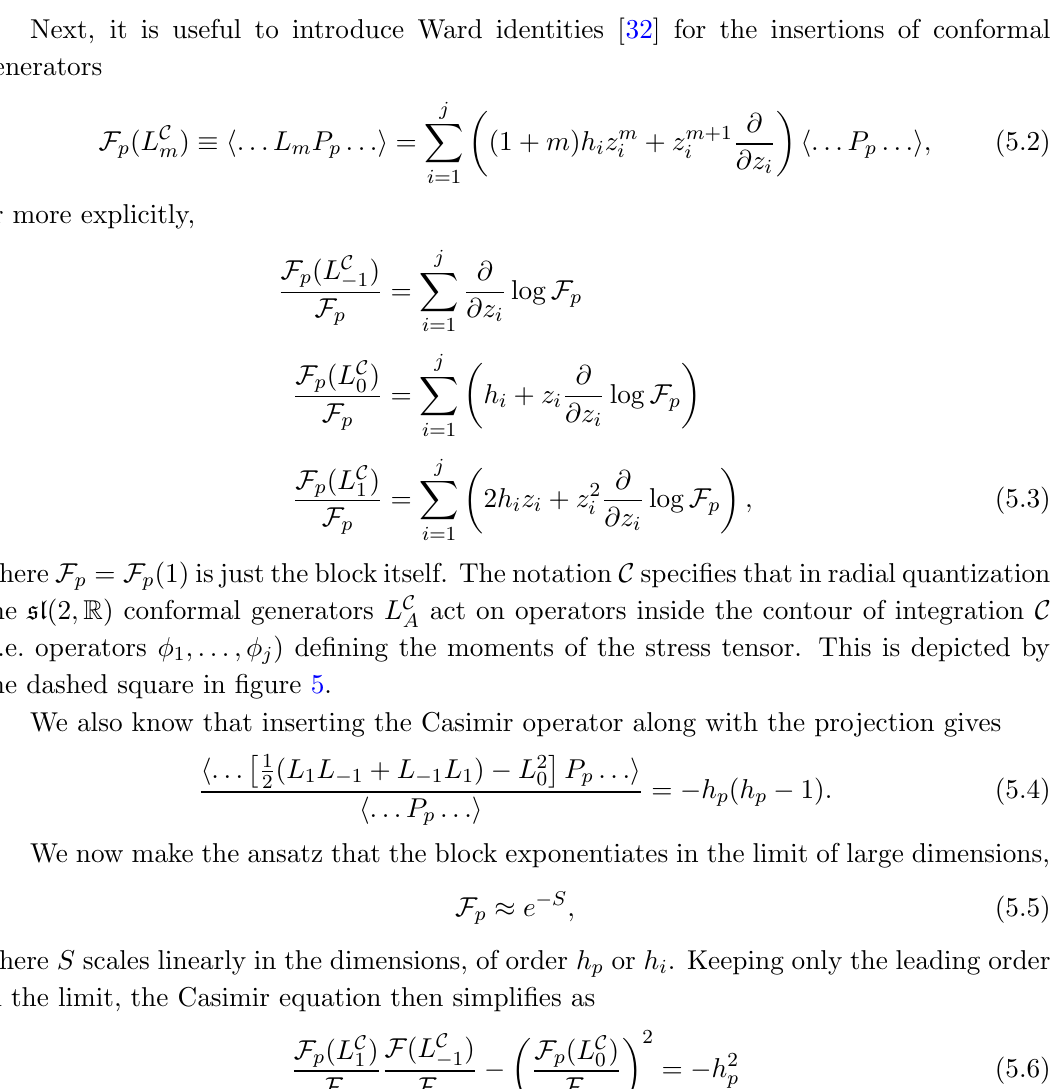
Figure 5 . An OPE channel where all the operators appearing to the right of P p (i.e. (cid:30) 1 ; : : : ; (cid:30) j ) are grouped inside the blue